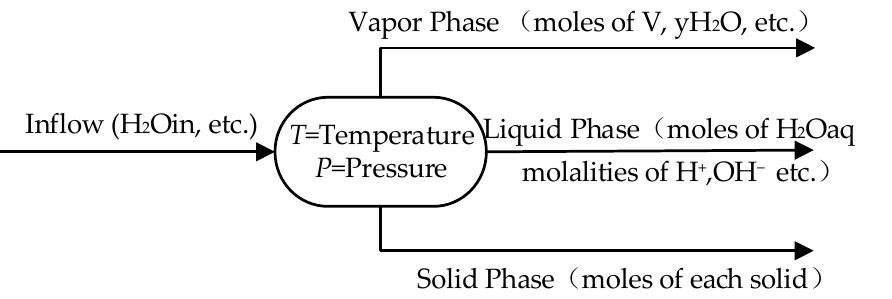
Figure 1. Schematic of phase equilibrium model of electrolyte solution. The equations involved are as follows.